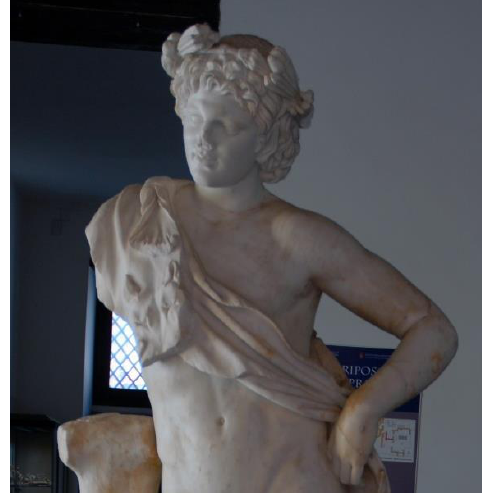
Figure 14. The Resting Satyr , details. The Satyr is in a frontal position, standing on an oval base and resting against a tree trunk on the right. Similar to other replicas, the Satyr has his head raised — slightly rotated to the right — the right shoulder higher than the left and the right leg flexed, rotated out- ward, and moved back to the left heel [72]. When the sculpture was discovered, it was fragmented and showed several repaired ancient damages. In particular, interventions were aimed at connecting “the based cracked in two parts, the tree trunk to the body of the Satyr , the right leg with the left heel and, finally, the pine twig on the right side of the forehead ” [ 72] (pp. 8 – 9). The connection between the several parts was made with iron bars fixed with lead. These elements caused further damage to the artwork and, in the recent restoration works, steel bars insured with epoxy resin were put in place to connect the many parts in which the sculpture was found, while the lacks were filled with plas- terworks aesthetically balanced [72]. The Resting Satyr is located on a small and low volume and is housed in one of the first rooms of the museum, introducing the visitor to the exhibition tour and to the knowledge of the history of the city and territory. The metric survey was the result of a scanning laser that required about three hours due to the presence of several details, such as the cape and the wreath around the head, which required more than one scan. About 350 circular markers were put on the statue ( Error! Reference source not found. ) at an average distance of 100 – 200 mm considering the smoothness of the surface. After the scanner calibration, the software setting in VXelements, mainly the automatic optimization of the shutter (to set the best frequency rate of the acquisition, according to the color and reflectance of the surface) and the resolution value (0.05 mm), was carried out. Due to these markers, a network of reference points can be acquired according to the local and global configuration of the surface. Similarly to the Mater Matuta , the editing of the model was carried out, resulting in a three-dimensional model characterized by about 5.8 M of vertices and 11.0 M of triangles ( Error! Reference source not found. ).